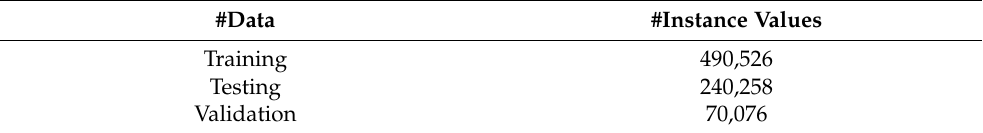
Table 5. Splitting the dataset.